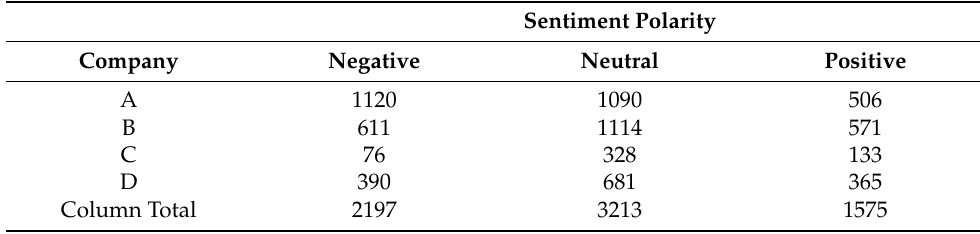
Table 5. Sentiment polarity of four companies.